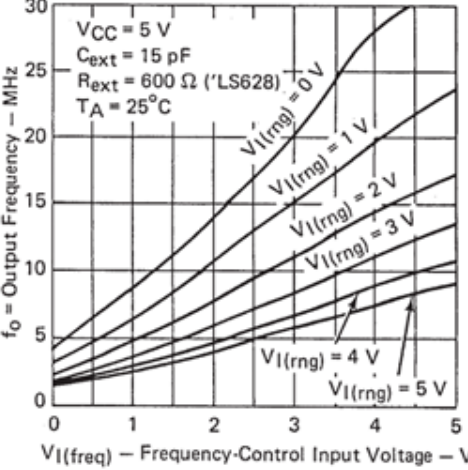
Figure 12. Output frequency versus frequency-control input voltage of the SN54LS628 (courtesy of